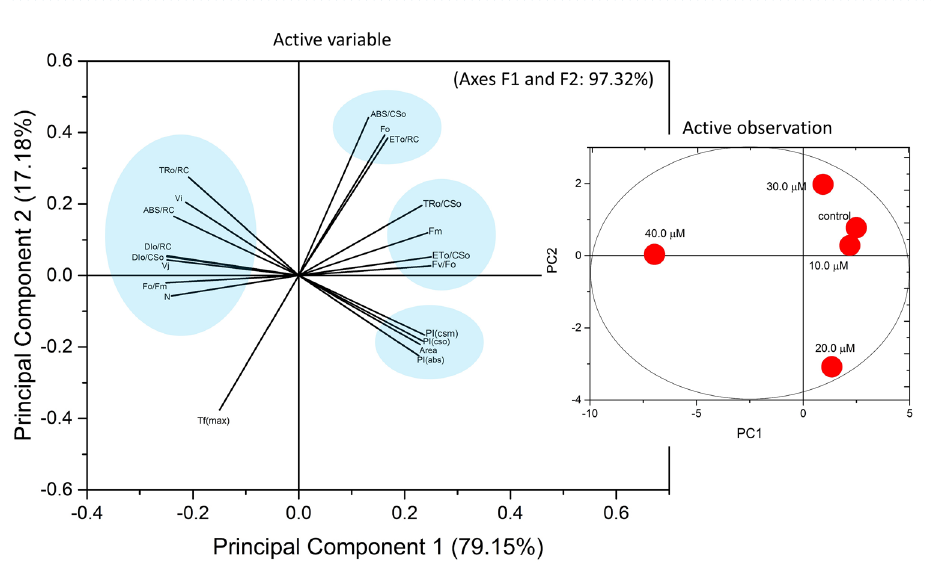
Figure 6. The principal component analysis with four Cu treatment conditions. The PCA is based on the chlorophyll fluorescence data. Arrows represent the Chlorophyll a fluorescence parameter on the corresponding dimensions (PC 1 and PC2), where PC 2 expressed most of the variability in the